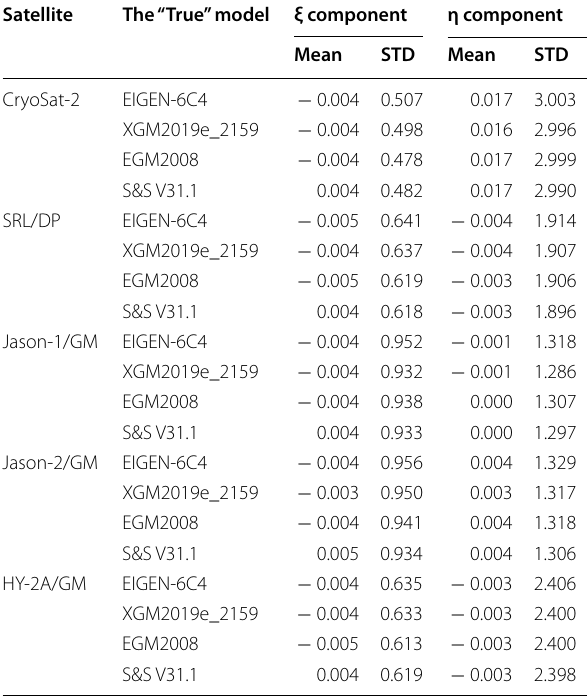
Table 3 Accuracy statistics of deflections of the vertical from the five altimetry satellites in global marine area (Latitude: Satellite